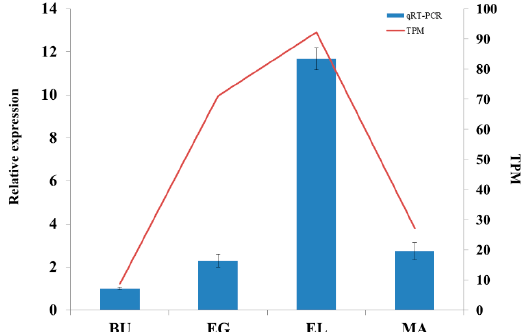
Figure 2. The expression analysis of Vvlcc3 using DGE and qRT-PCR. TPM: Transcripts per Million clean tags. BU (Button stage): the stage after inoculating spawn 10 days on rice straw compost; EG (egg stage): the stage after inoculating spawn 13 days; EL (elongation stage): the stage after inoculating spawn 13.5 days; MA (maturation stage): the stage after inoculating spawn 14 days.